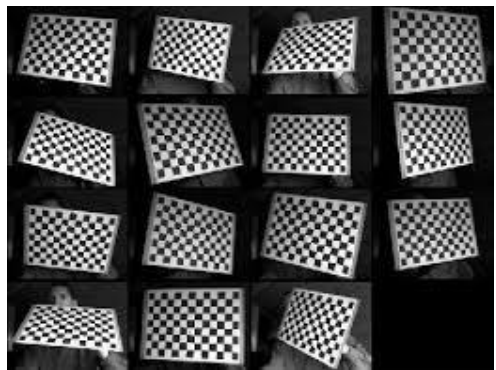
Figure 1: Chessboard calibration pattern